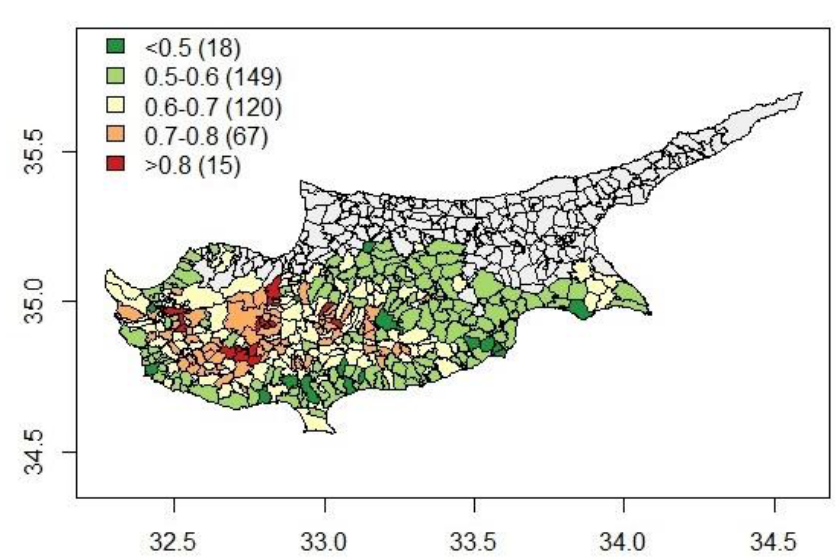
Figure 4. Choropleth map of the CRC Mortality-To-Incidence ratio (M/I ratio).